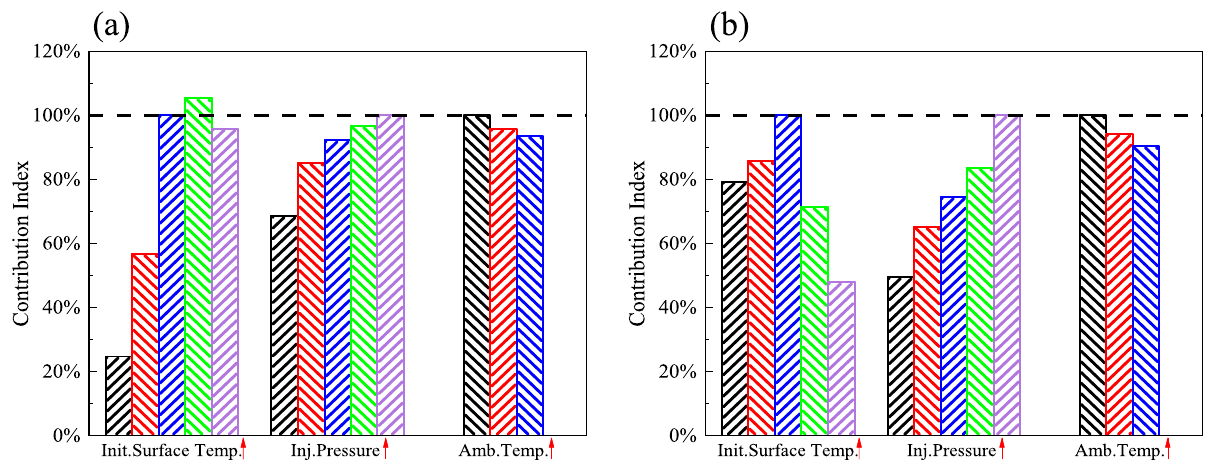
Figure 7. Contribution Indexes of different experimental factors ( T init , P inj , T amb ) on ( a ) q s and ( b ) h .